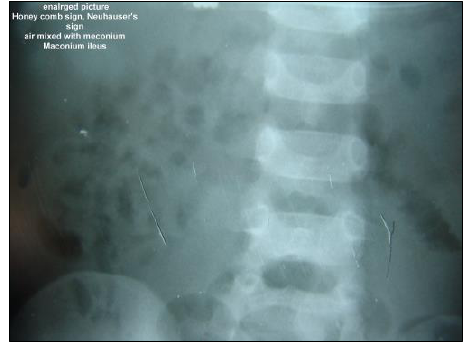
Figure 4: Neuhauser’s sign in meconium